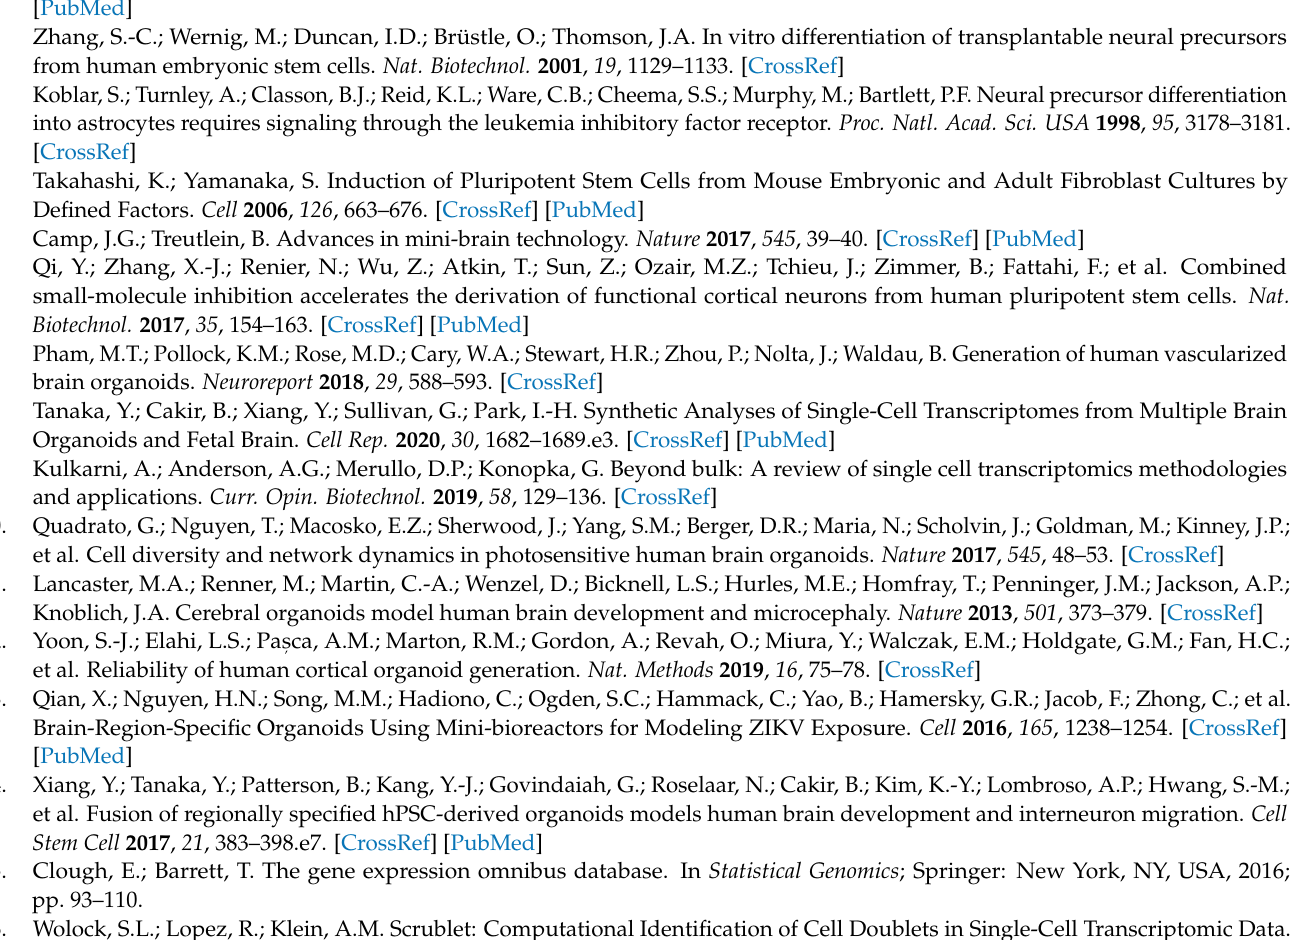
and fetal brain samples. Figure S2. GSEA analysis of developmental genesets (axon development, Notch signaling and neuron differentiation) between organoid and fetal groups. Figure S3. Cell type specific developmental trajectory in radial glia, astrocytes and OPCs across timepoints of 1–26 weeks. Figure S4. Gene set enrichment analysis of functional pathways relevant to astrocytes in organoid cultures and fetal brain at 3-month and 6-month